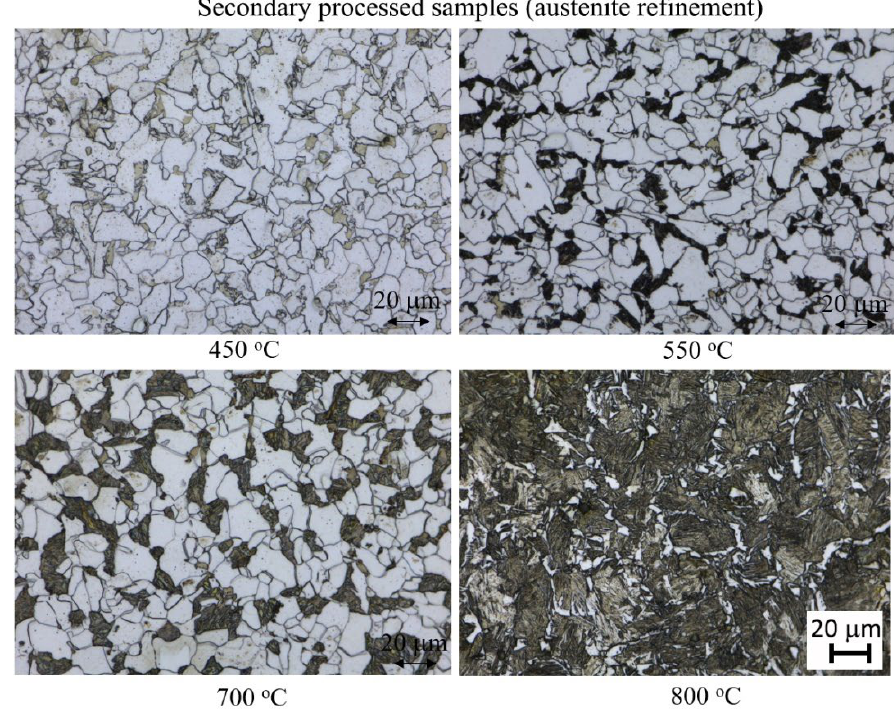
Figure 4. Microstructure of samples after secondary processing at different heat treatment temperatures as indicated. Heat treatment time was 5 min. All micrographs shown at the same magnification.